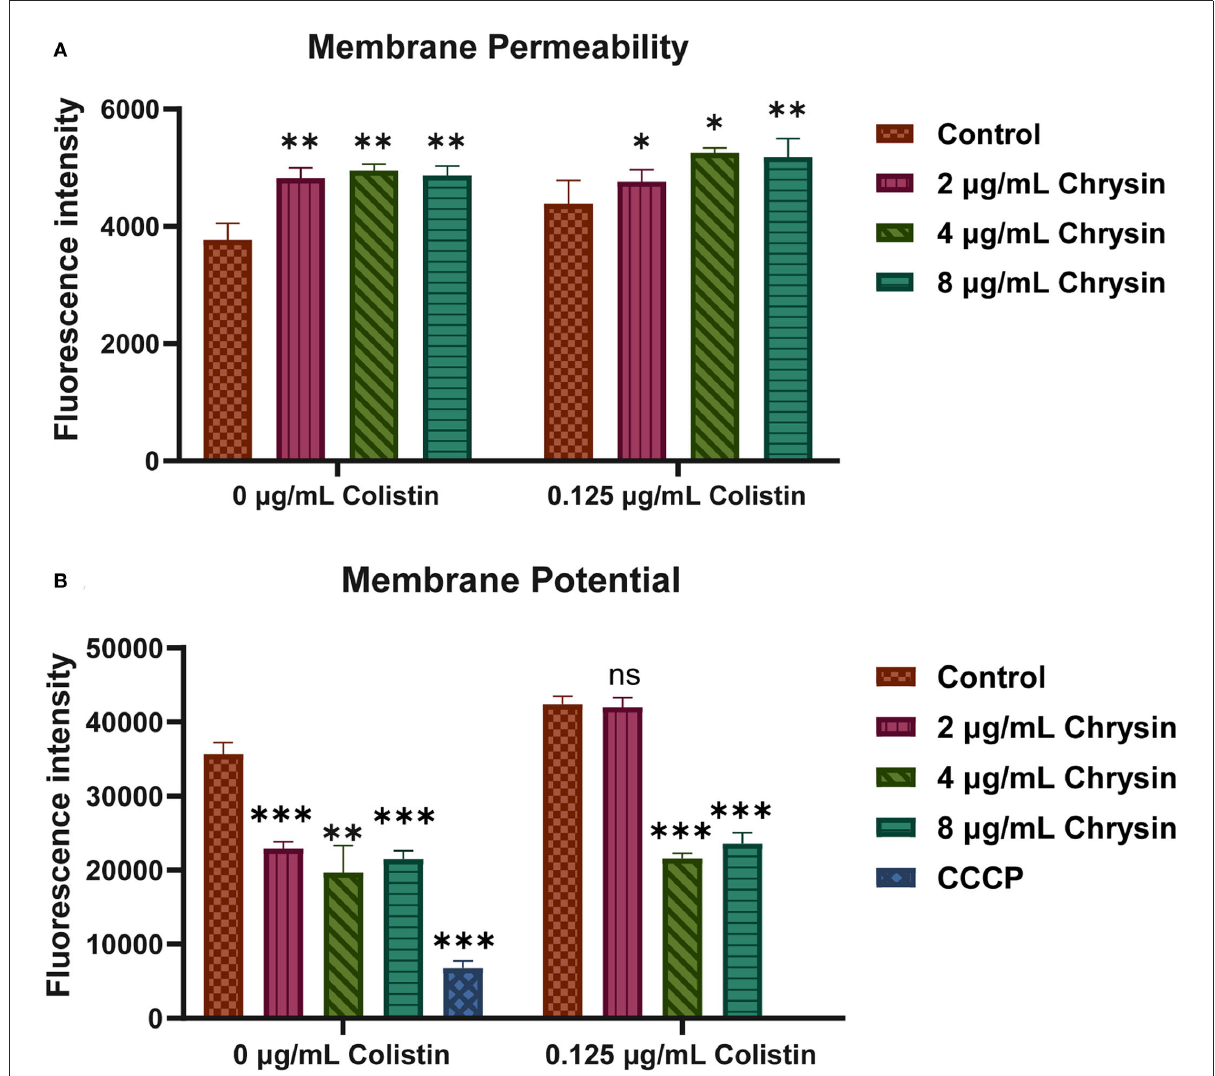
FIGURE5 The mechanism of synergystic activity of chrysin and colistin. (A) The membrane permeability of A. baumannii BM2622 treated with chrysin and colistin or monotherapy. (B) The potential of the cell membrane of A. baumannii BM2622 treated with chrysin and colistin or monotherapy. p < 0.05 (noted with*), p < 0.01 (noted with**), and p < 0.001 (noted with***), data are expressed as the mean ± SD of three